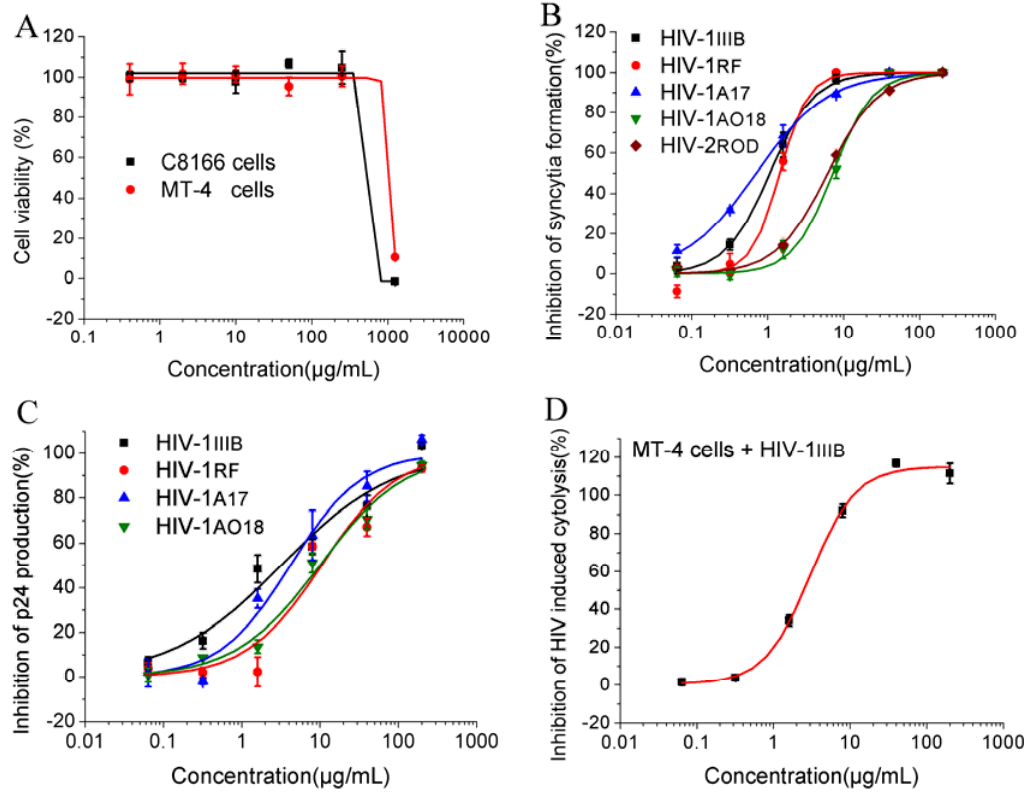
Figure 1. Cytotoxities and anti-HIV activities of YNS-PY-F. Cytotoxities on C8166 and MT-4 cells were measured by MTT assay ( A ); Inhibitory activities on HIV-1 HIV-1 , HIV-1 and HIV-2 in C8166 cells were measured by syncytia reduction A17 AO18 ROD assay ( B ); Inhibitory activities on acute replication of HIV-1 HIV-1 in C8166 cells were measured by quantification of p24 antigen production ( C ); AO18 Inhibitory activity on HIV-1 induced cytolysis in MT-4 cells was measured by MTT assay IIIB ( D ). The data shown in the figure are a representative of at least two independent